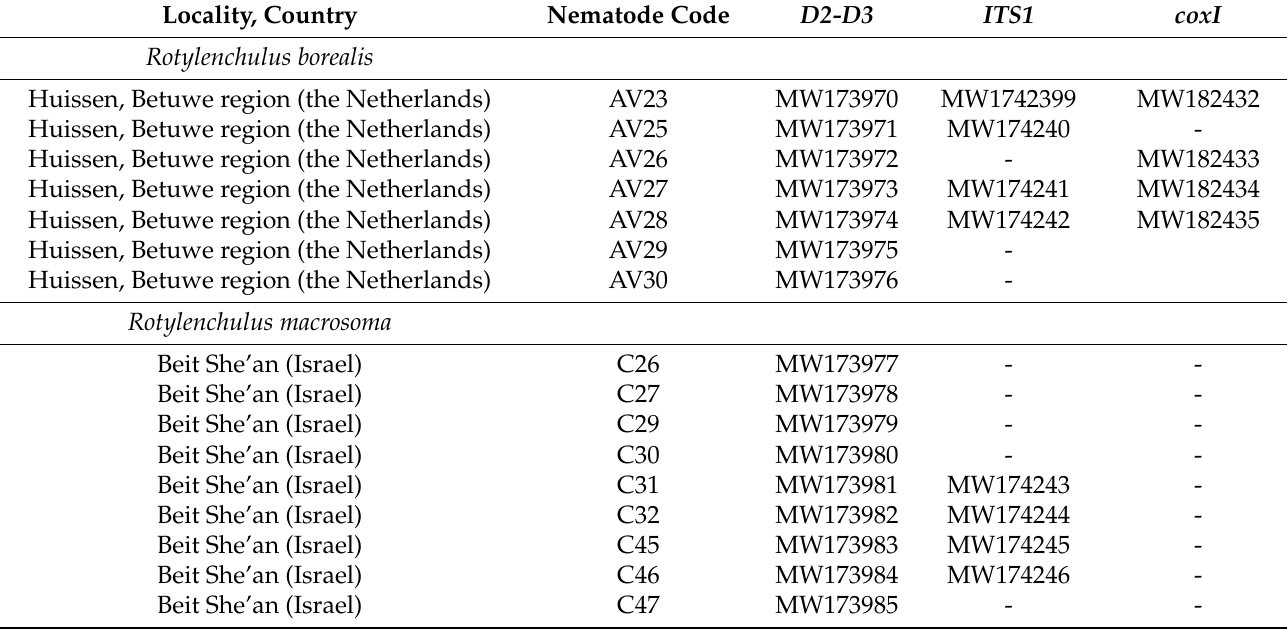
Table 1. Populations sampled for Rotylenchulus spp. from two localities in the Netherlands and Israel used in this study. Locality, Country